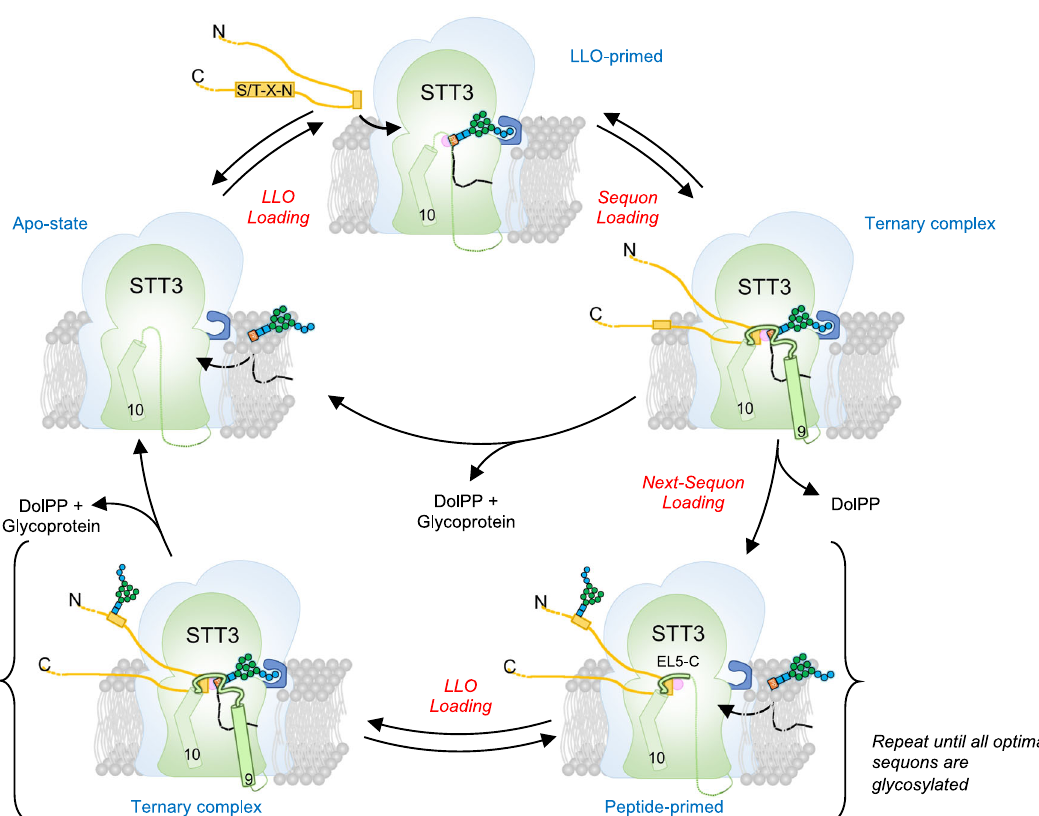
Fig. 5 | Proposed glycosylation cycle of OST. Apo-state: in the absence of bound substrates, EL5 and TM9 of STT3 are shown as a dashed line, indicating fl exibility. LLO-primed: OST bound to donor substrate, with EL5 and TM9 remaining fl exible. The terminal Glc 3 moiety is accommodated in the Glc 3 -binding pocket. Ternary complex : binding of donor and acceptor substrates promotes engagement of